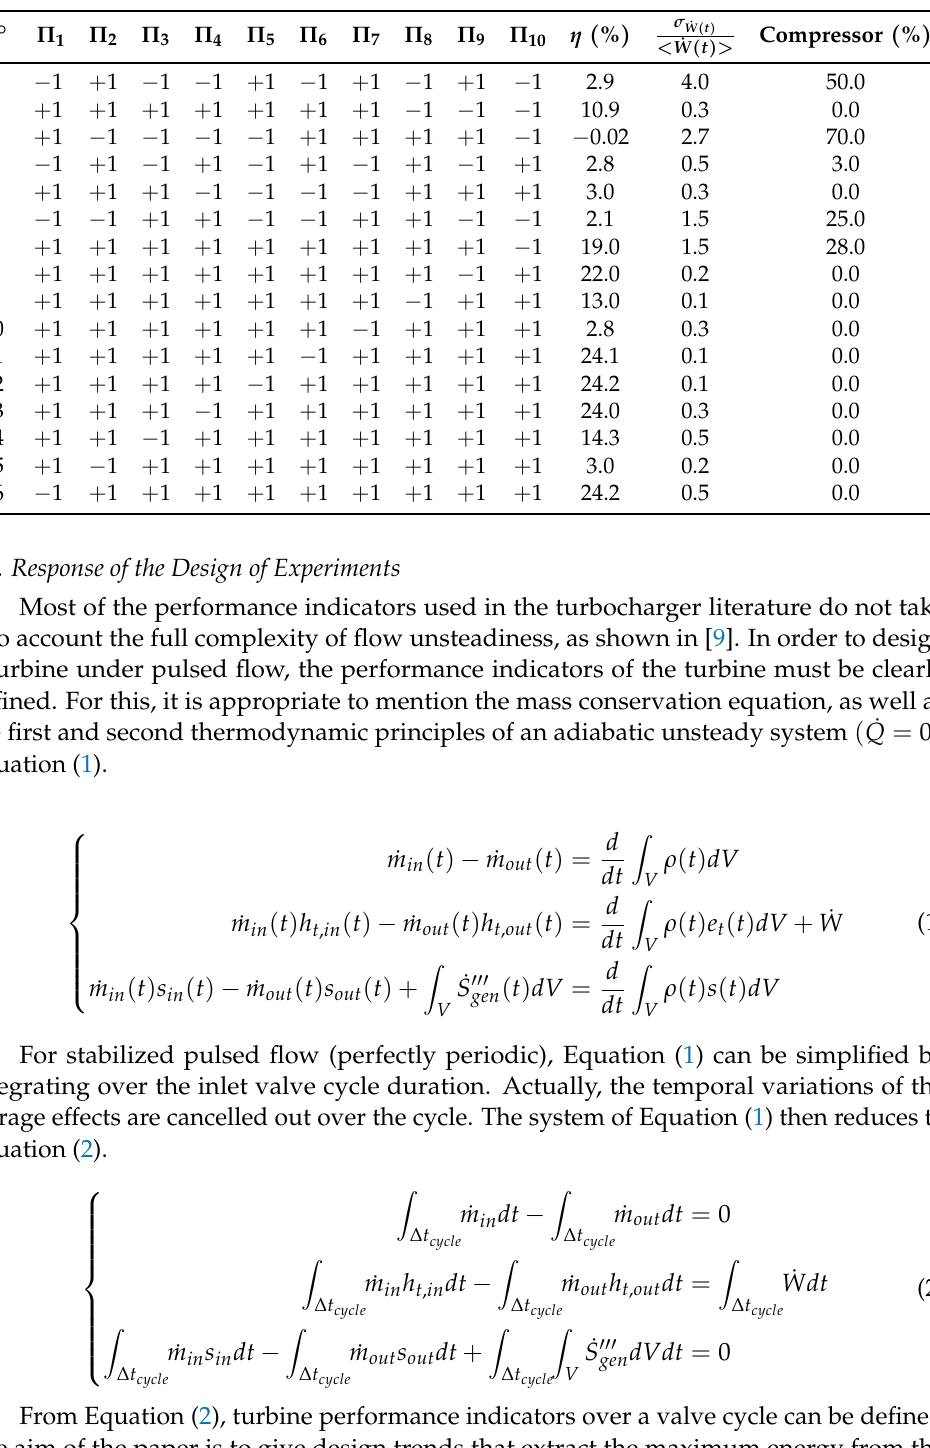
Table 1. Screening design and associated